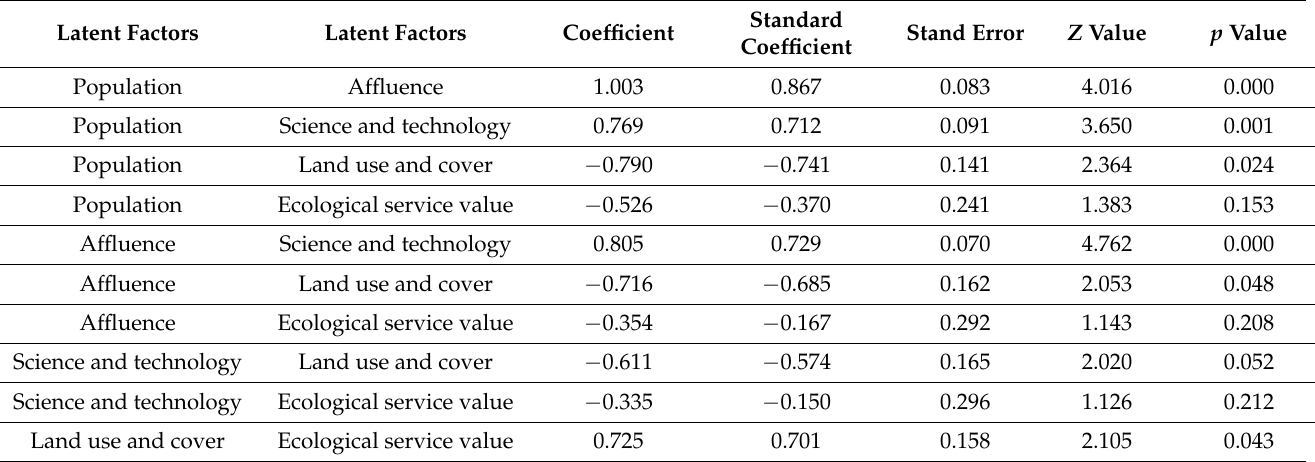
Table A4. The regression coefficients between latent